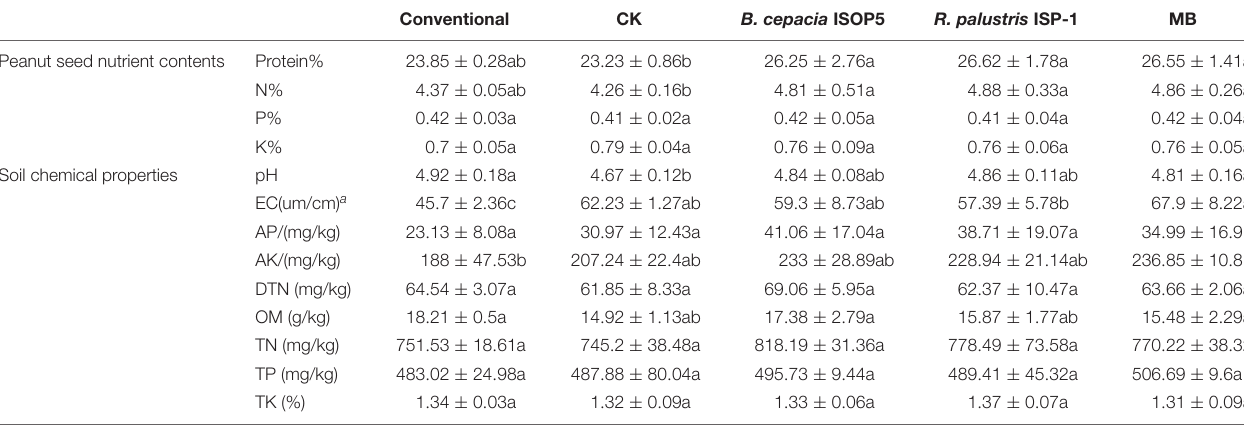
TABLE 2 | Nutrient contents in peanut seeds and soil physicochemical properties in the 5th year of harvest.